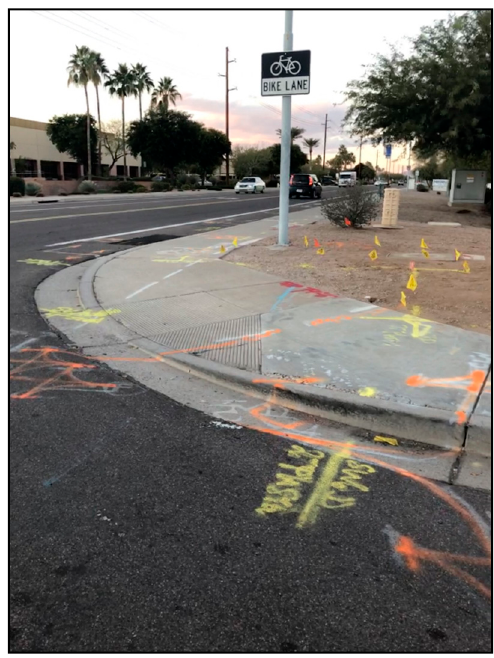
Figure 1. An example of using spray paint and flags to reflect the location of utilities.